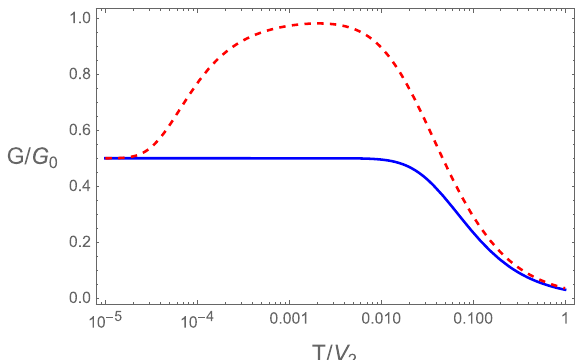
Figure 5. Normalized conductances as a function of temperature for a system consisting of two semi-infinite Rice–Mele chains attached to a quantum dot at the topological phase transition of the chains ( ˜ V = 1 ). In blue 5 continuous ǫ/ V 2 = 0.1 , and in red dashed ǫ/ V 2 = 5 × 10 − . In both cases, the low temperature saturation value G / G 0 = 1 / 2 gives evidence of fractional charges flowing in the system. The curves for G / G 0 are independent of the coupling to the quantum dot and of the sign of ǫ , for µ = ǫ and the dot in resonance with the edge mode. Notice that for small values of ǫ/ V 2 as temperatures increases there is a kind of recombination of the fractional charges.